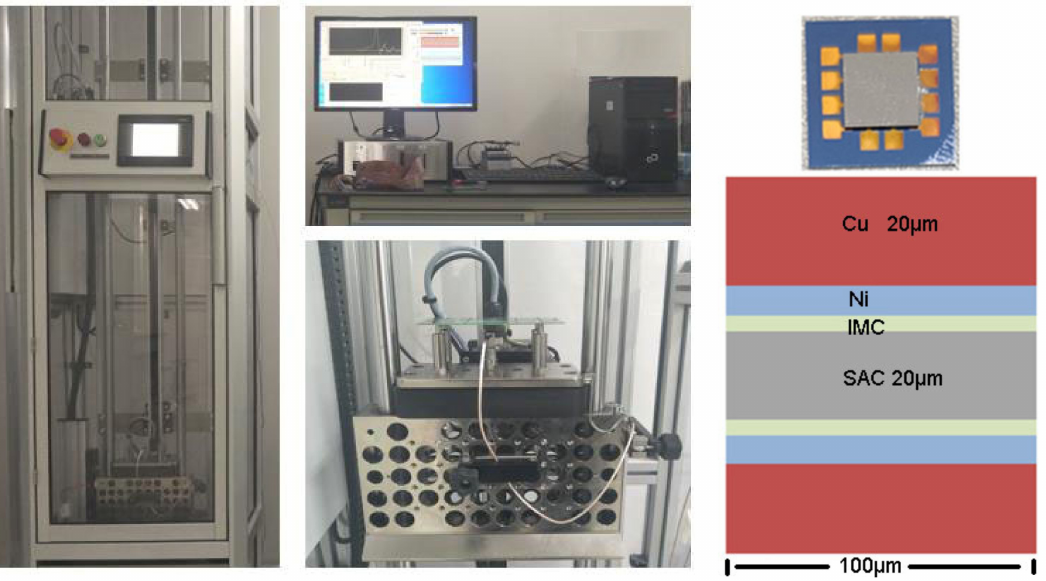
Figure 1. The schematic diagram of drop test and the cross-section images of the unit of the daisy chain.